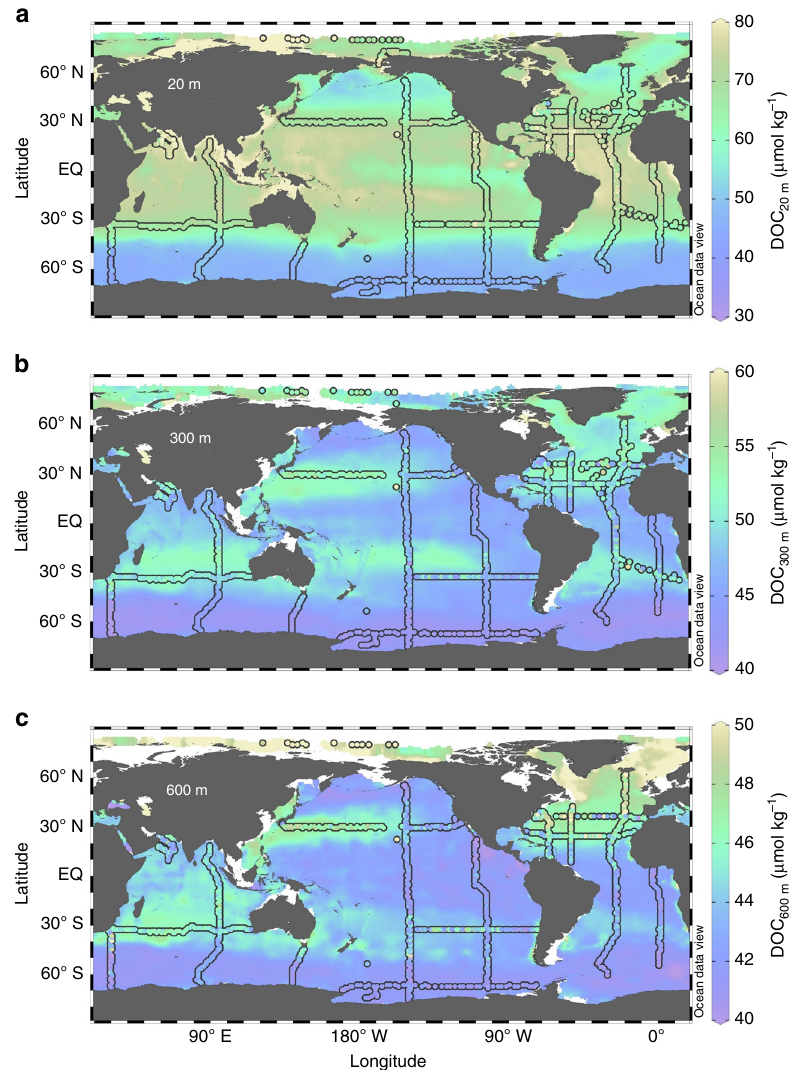
Fig. 1 Distribution of ANN-derived and observational DOC. Color map is the arti fi cial neural network (ANN)-derived dissolved organic carbon (DOC) concentration, and colored dots are the observed DOC concentration at 20 m ( a ), 300 m ( b ), and 600 m ( c ). ANN-derived DOC correlates with ~30,000 observed DOC data points with slope = 1.00, R 2 = 0.95, and RMSE = 2.37 μ mol kg − 1 . A correlation study of data points in the upper 74 m indicates slope